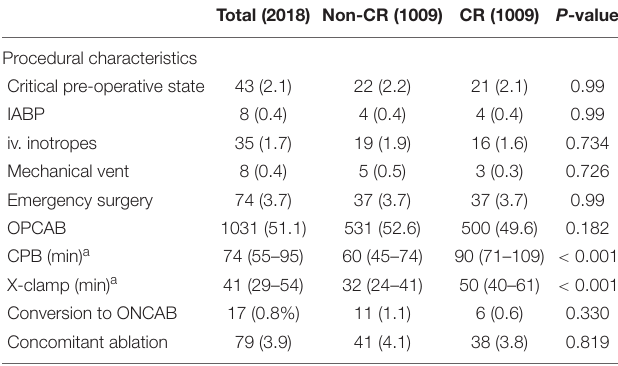
TABLE 2 | Operative characteristics after PS-matching.